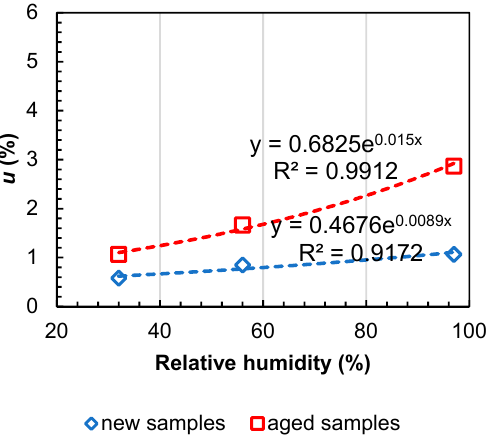
Figure 3. Moisture content ( u ) at different relative humidities: comparison between the new and aged samples.